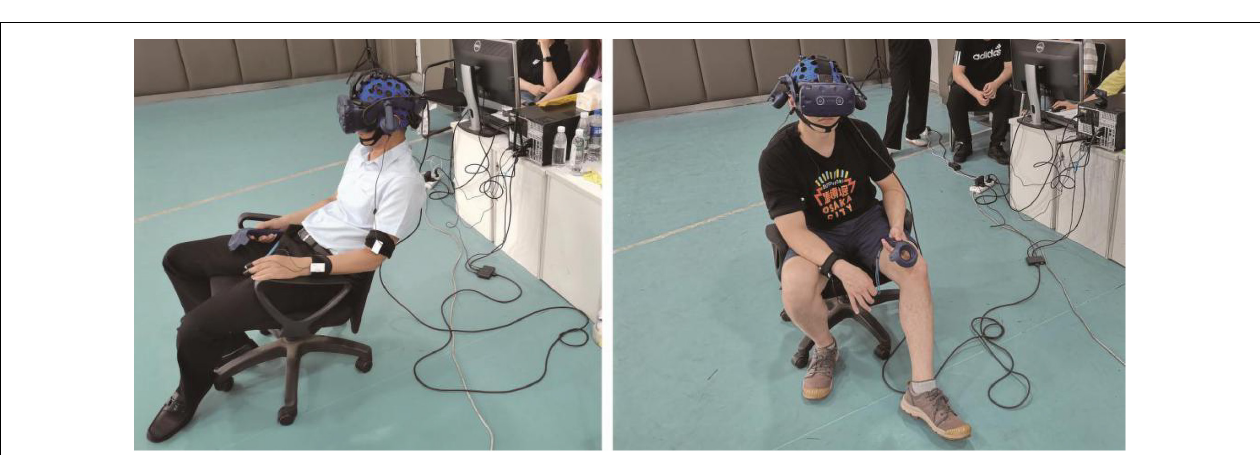
FIGURE 5 | Image recording of field experiments on testees (Photography by our research team at the experimental site).